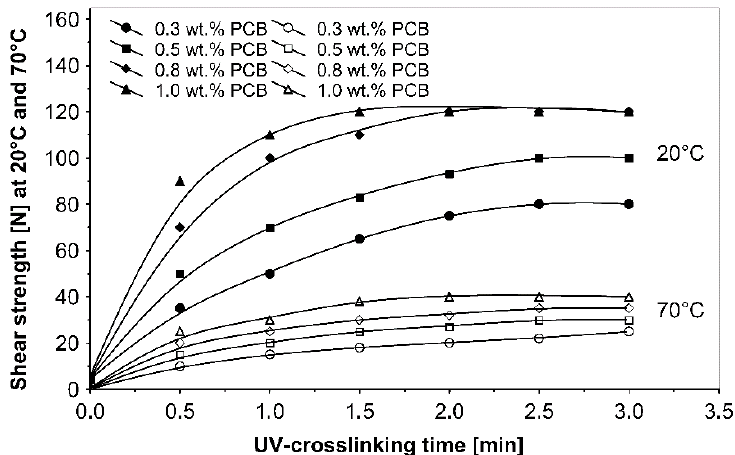
Figure 6. Peel adhesion of cross-linked acrylic PSAs containing various amounts of additionable photoinitiator versus UV-crosslinking time .